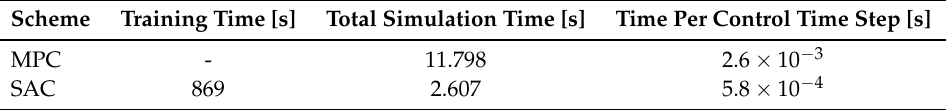
Table 3. Training time (if applicable), mean total simulation time and time per control time step for the simulations used to verify and compare the MPC and SAC control